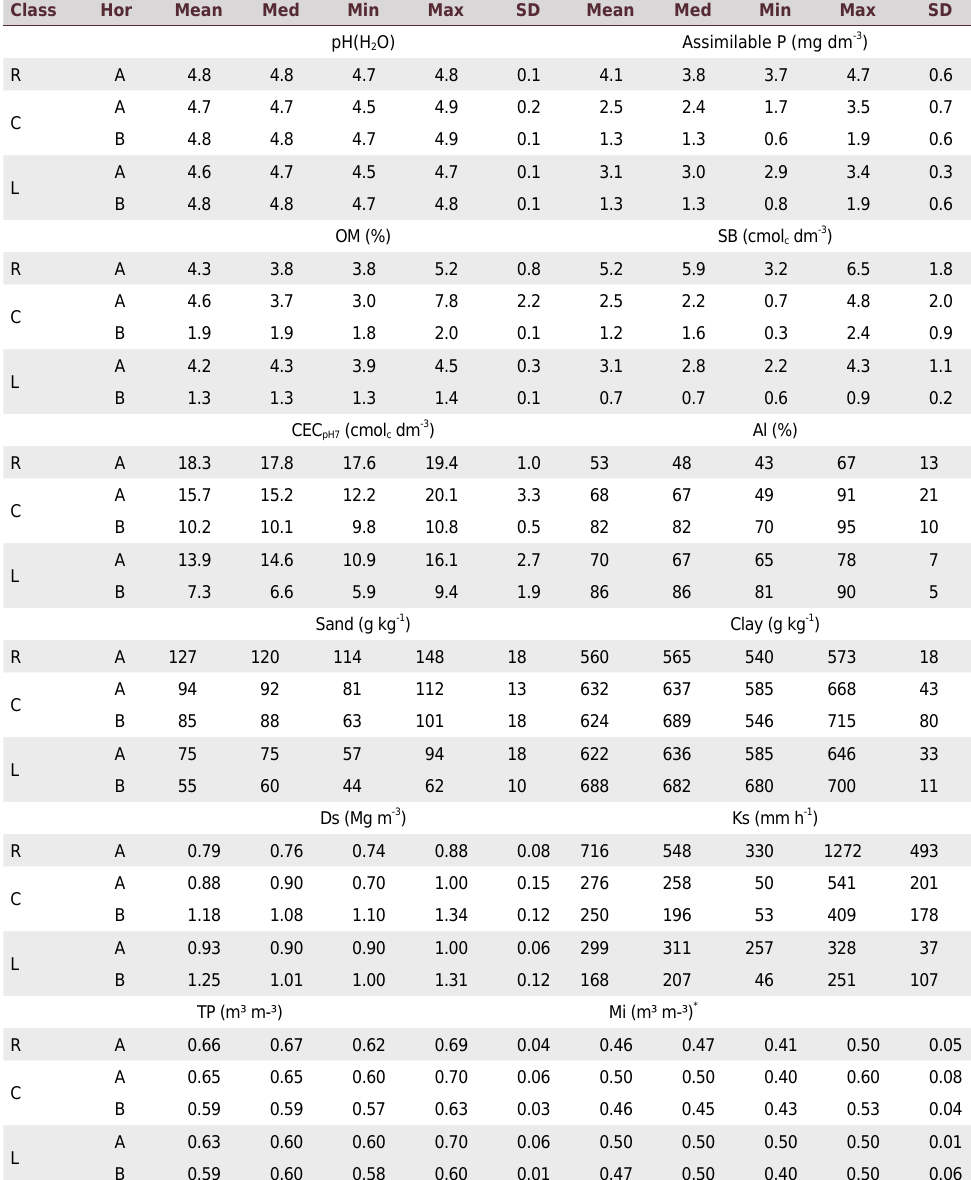
Table 4. Descriptive statistics of chemical and physical variables of soil dataset